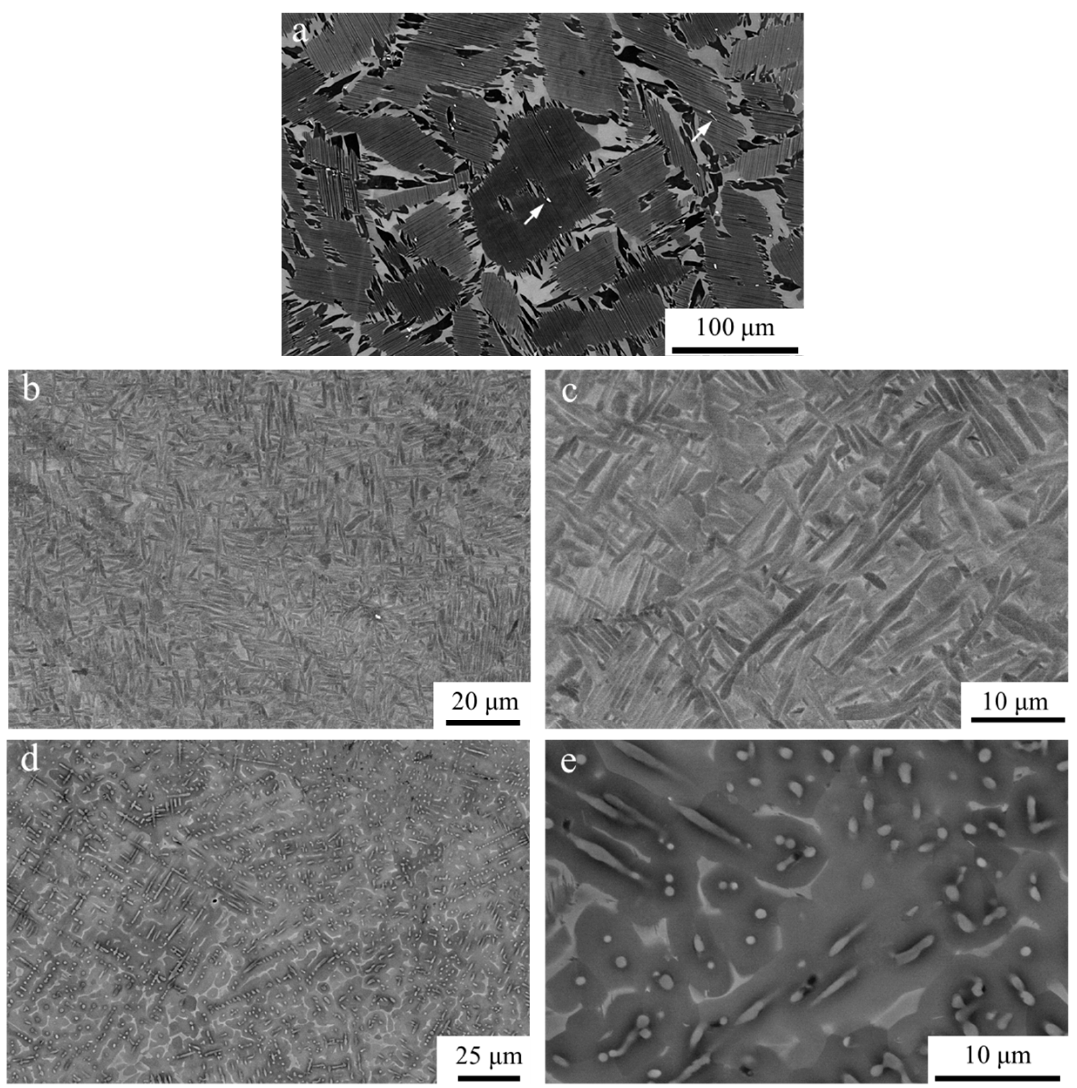
Figure 2. Microstructure of ( a ) base metal, ( b , c ) weld zone of sample 1#, ( d , e ) detailed microstructure of weld of sample 2# in backscattered electron (BSE) mode SEM image taken from the area and detailed microstructure.